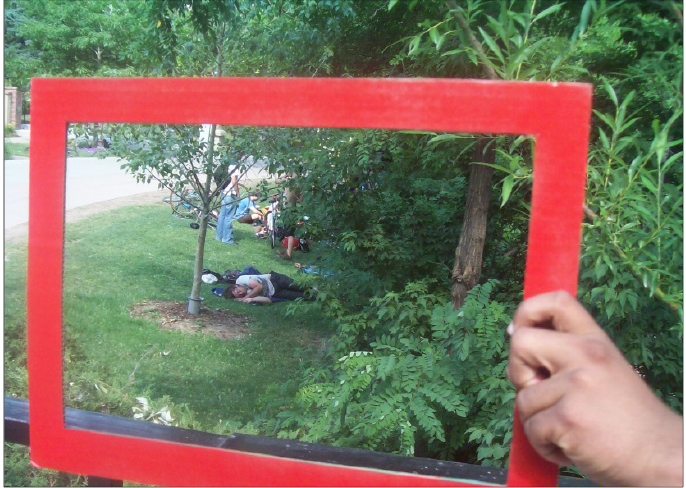
Figure 6. Students highlight their discomfort with Boulder’s homeless population in the Civic Area (photo courtesy of GUB).